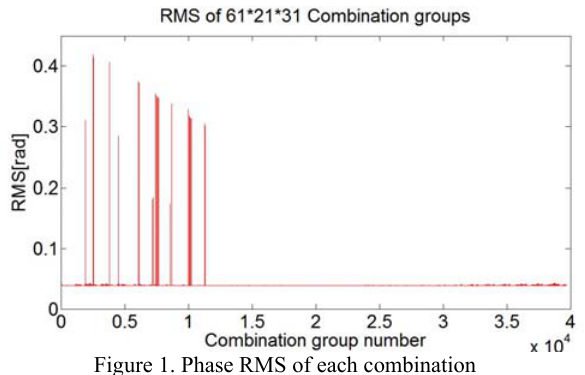
Figure 1. Phase RMS of each combination